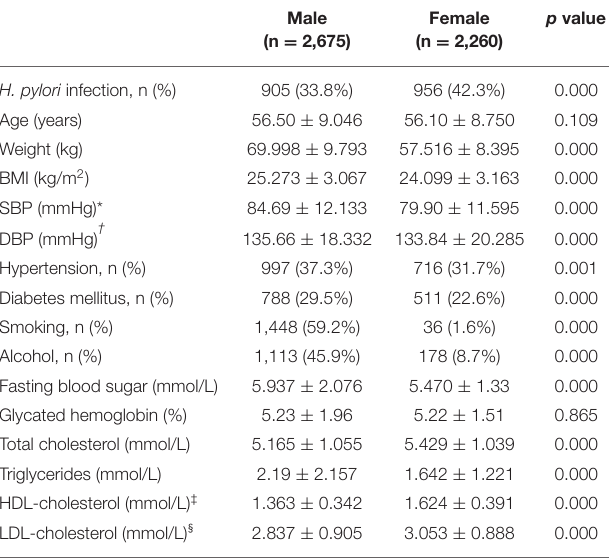
TABLE 2 | Gender difference analysis in intracranial atherosclerosis patients. TABLE 3 | Risk factors for intracranial atherosclerosis in female patients under 60